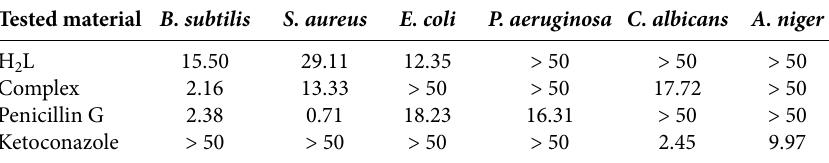
Table 3. IC 50 values (μg mL –1 ) of the tested material Tested material B.